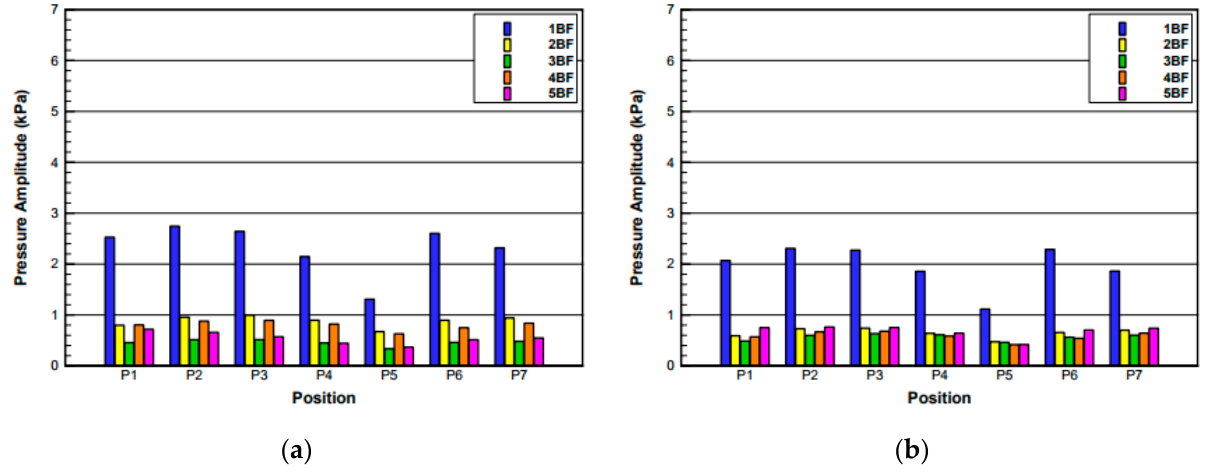
Figure 20. Full ‐ scale pressure fluctuations, first to fifth blade frequency at seven designated points ( a ) Bare; ( b ) with ESD.